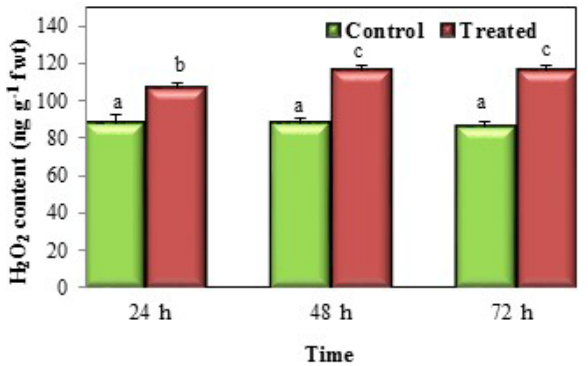
Figure 1. H 2 O 2 content in treated and untreated plants of Chenopodium album at different times. Data are mean values ± SD of four experiments. Bars with different let- ters were significantly different ( P <0.05) from each other. f wt = fresh